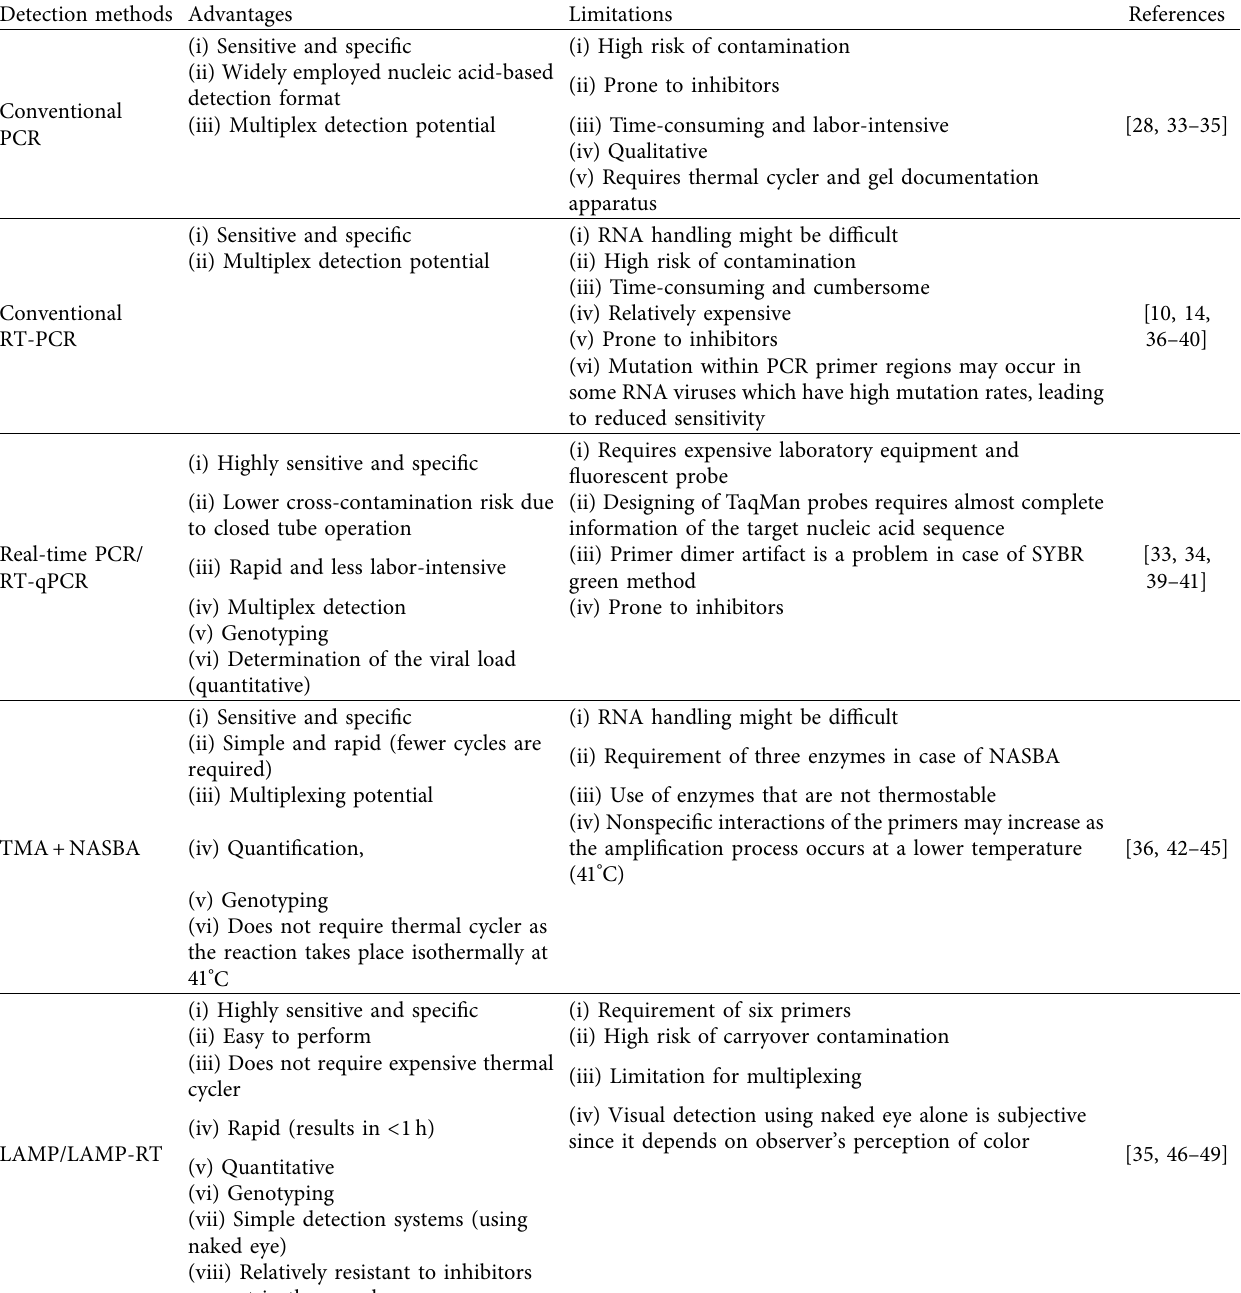
Table 1: Advantages and limitations of nucleic acid-based amplification